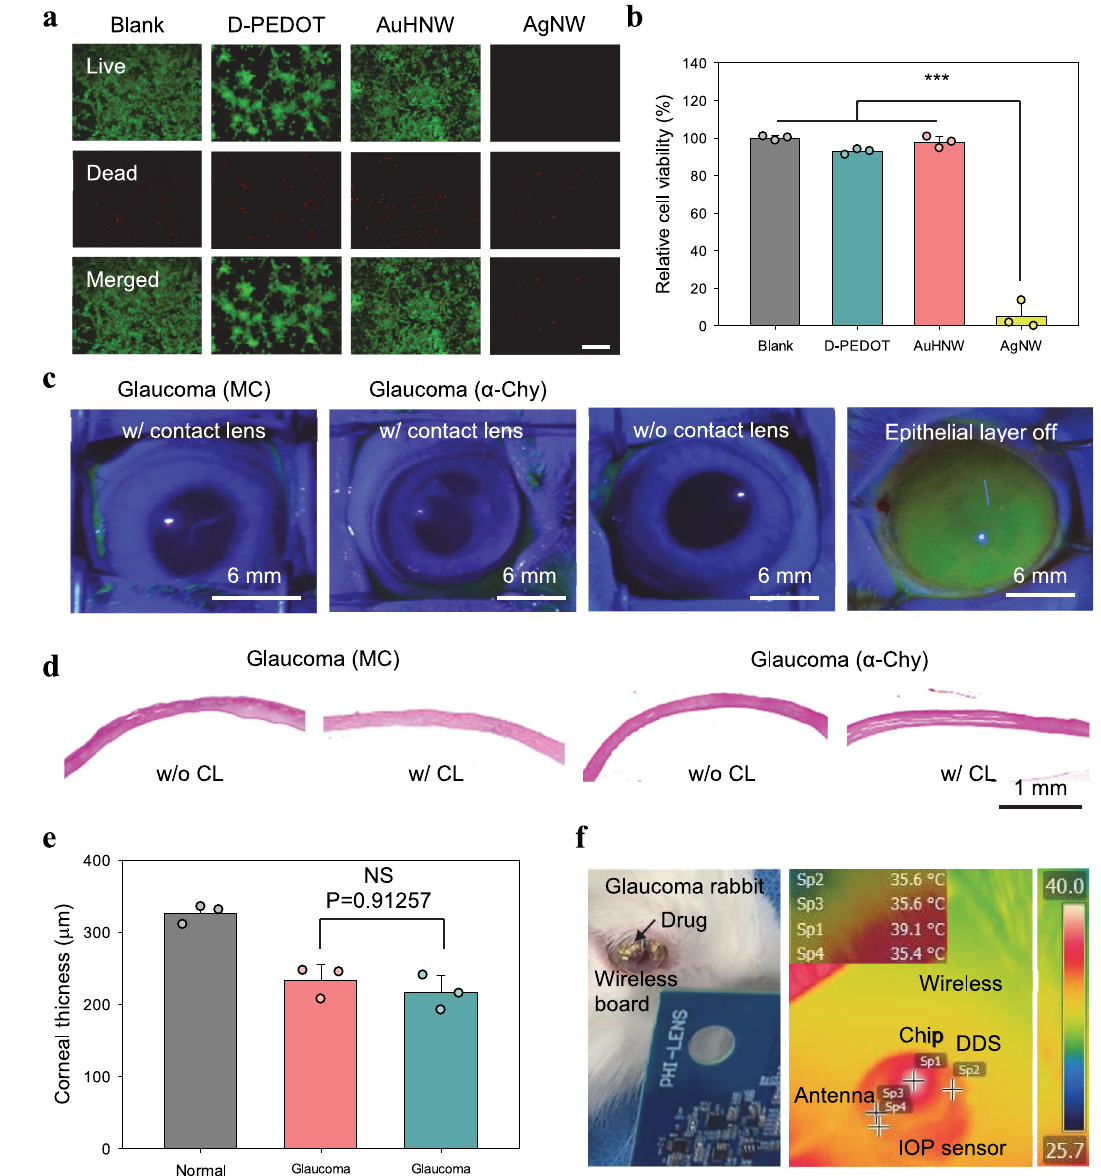
Fig. 5 | Biosafety assessment of nanomaterials and smart contact lens. a Fluorescent microscopic images of NIH 3T3 cells after the live/dead assay (scale bar, 200 μ m). b The relative cell viability of each sample ( n =3 independent experiments,*** P =0.00003forBlankandAgNW,*** P =0.00004forD-PEDOTand AgNW, *** P =0.00004 for AuHNW and AgNW). c Fluorescein staining for